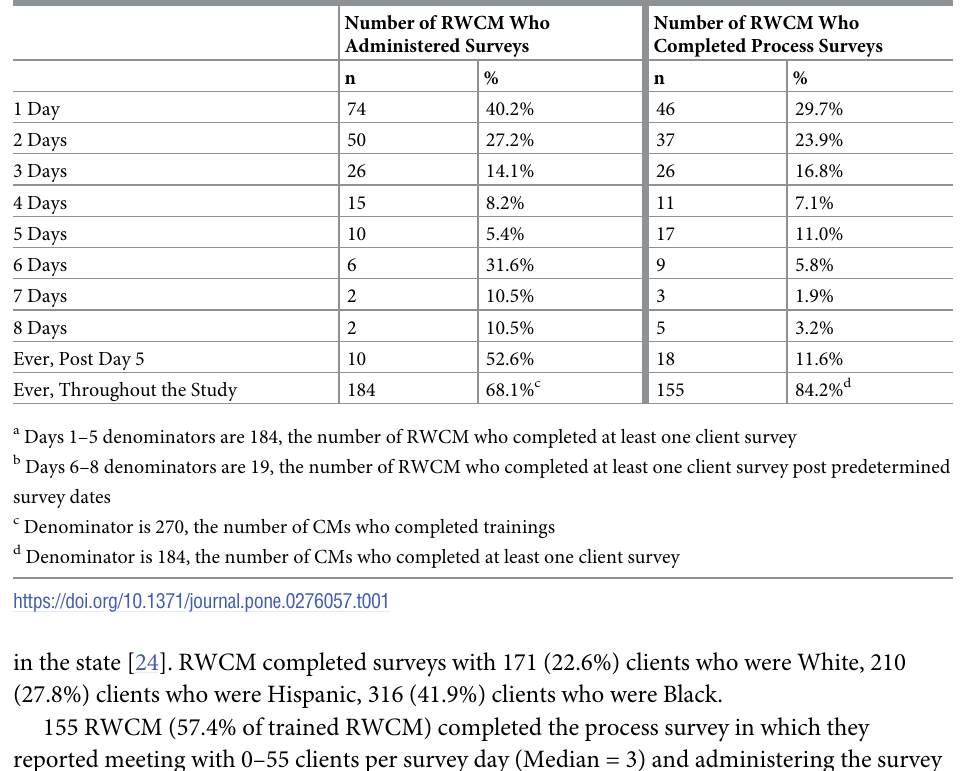
Table 1. Ryan White Case Managers (RWCM) who administered